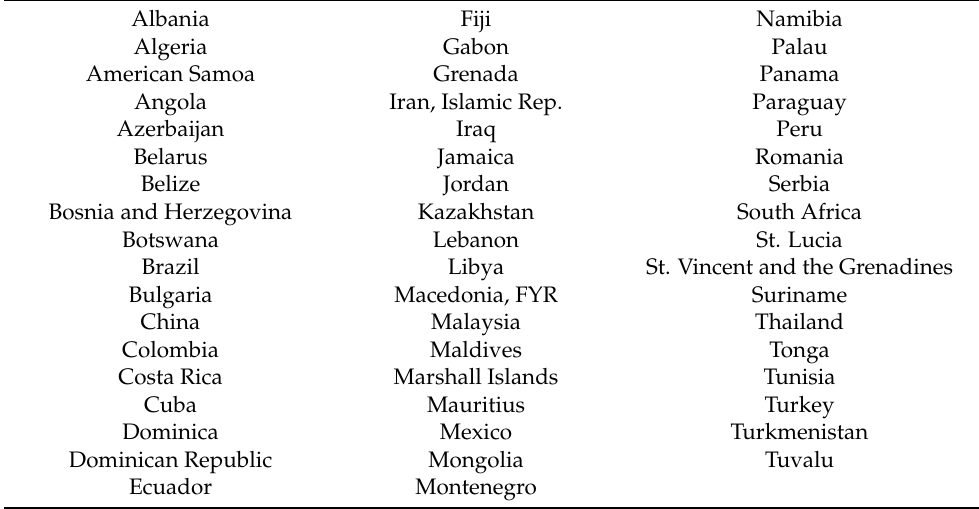
Table A3. List of high-middle economies ($4126 to $12,735$).